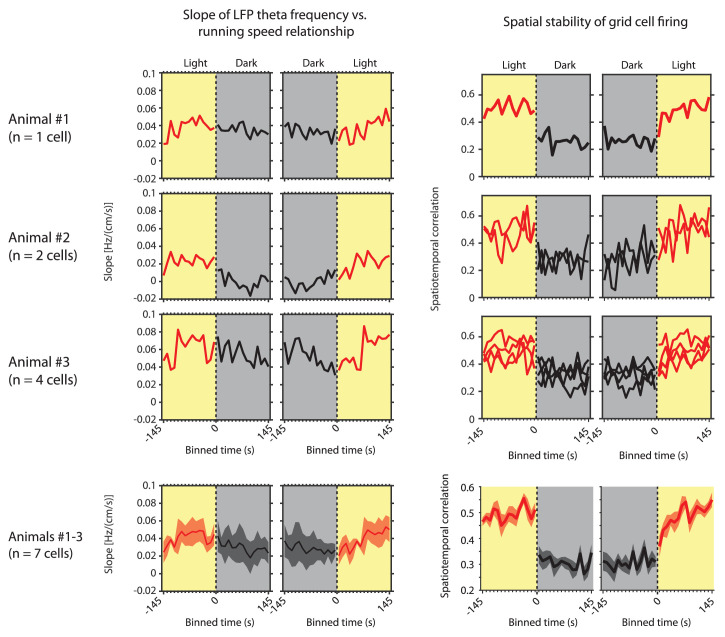
Left side shows the slope of the local field potential (LFP) theta frequency vs. running speed relationship as a function of 10 s time bins around the transition points from light to dark and from dark to light for the three individual mice in which grid cells could be recorded over multiple days and sessions.Right side shows the corresponding spatial stability of grid cells recorded in each of those mice as a function of 10 s time bins around the transition points from light to dark and from dark to light. The last row shows the same data for slope and grid cell stability as mean ± s.e.m. across mice or cells, respectively.